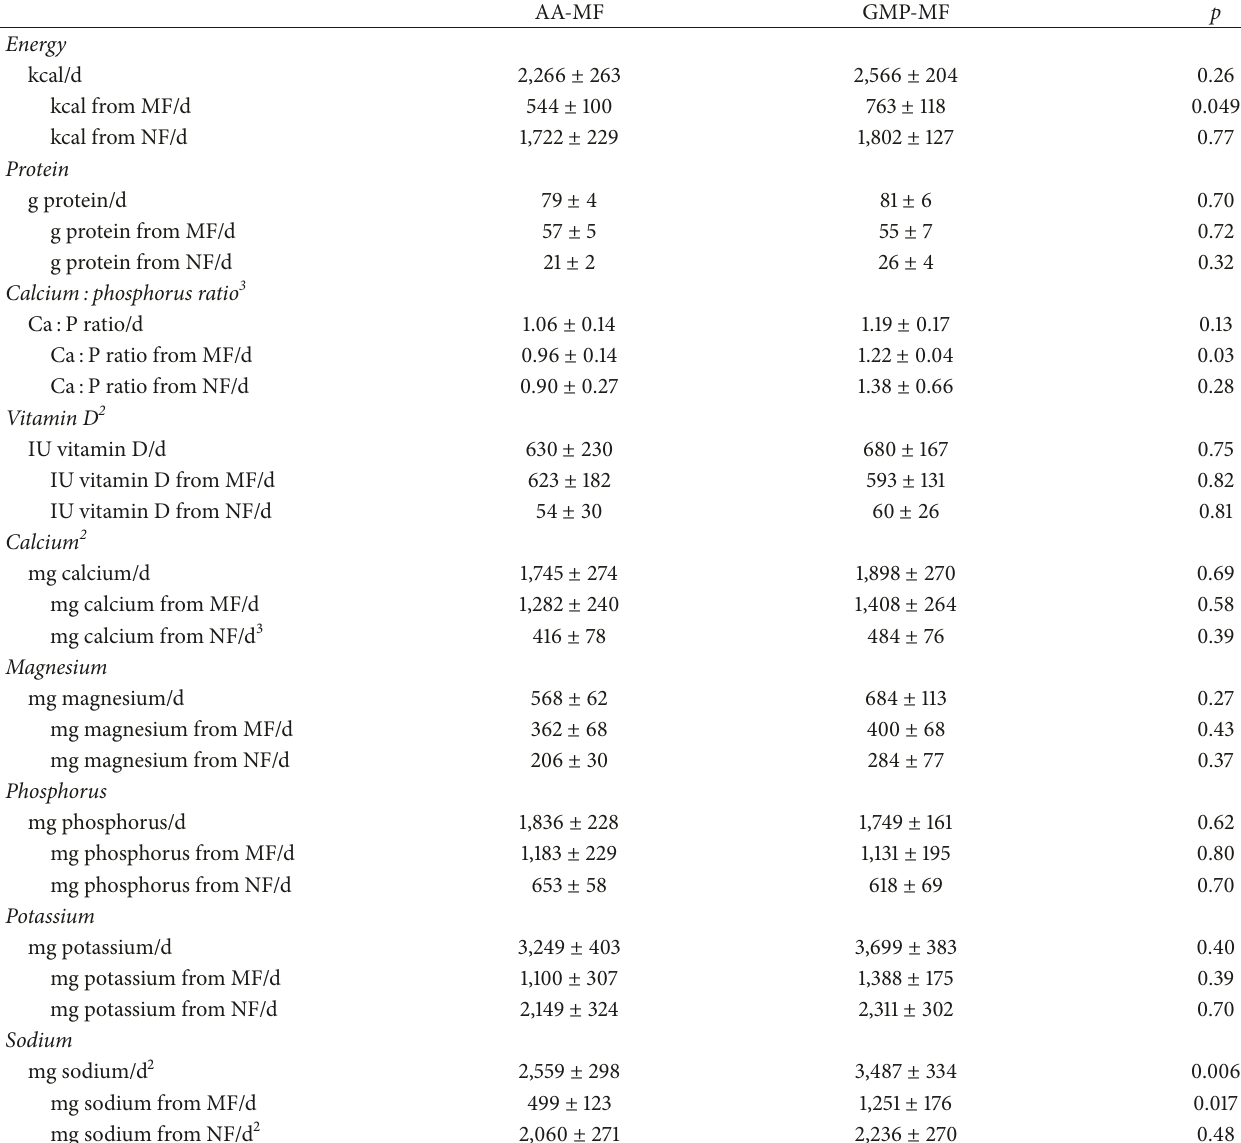
Table 2: Nutrient profiles of the low-Phe diet in combination with AA-MF and GMP-MF 1